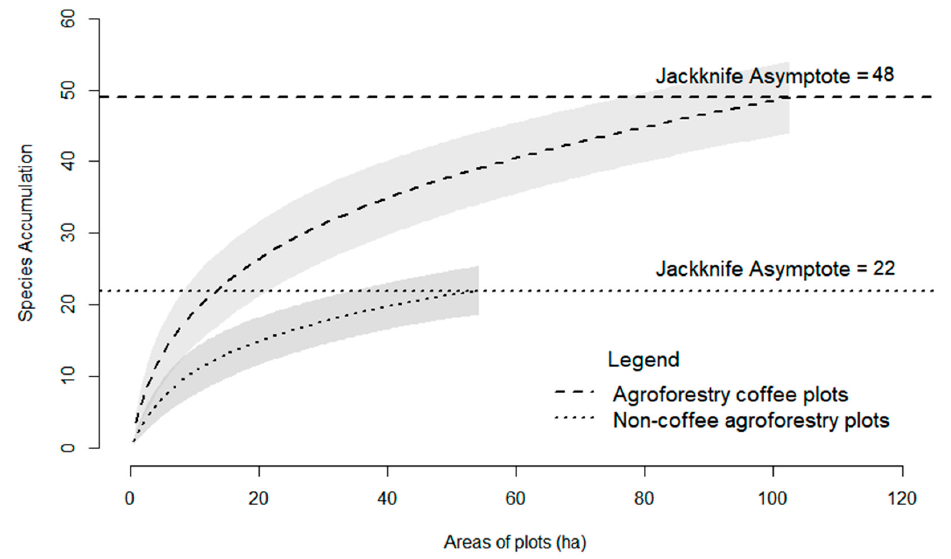
Figure 2. Species accumulations and first order Jackknife asymptotes by area from coffee agroforestry plots and non-coffee plots (orchards, annual crops, timbers).